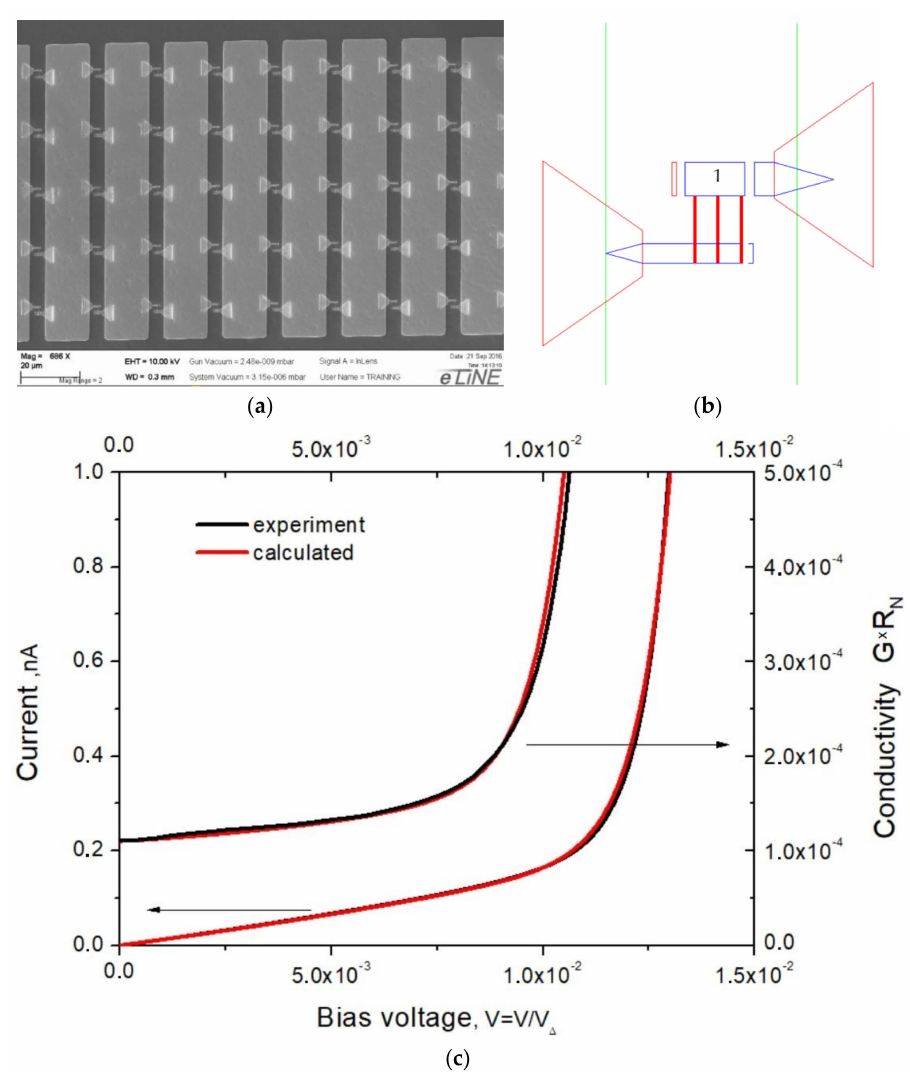
Figure 4. Photo of a fraction of multijunction NIS array thermometer ( a ), design of NIS junction 1 of the area 1 × 1.8 µ m 2 ( b ), IV curves and relative dynamic conductivity, experimental and theoretical curves including both Andreev’s current (1) and single-electron current ( c